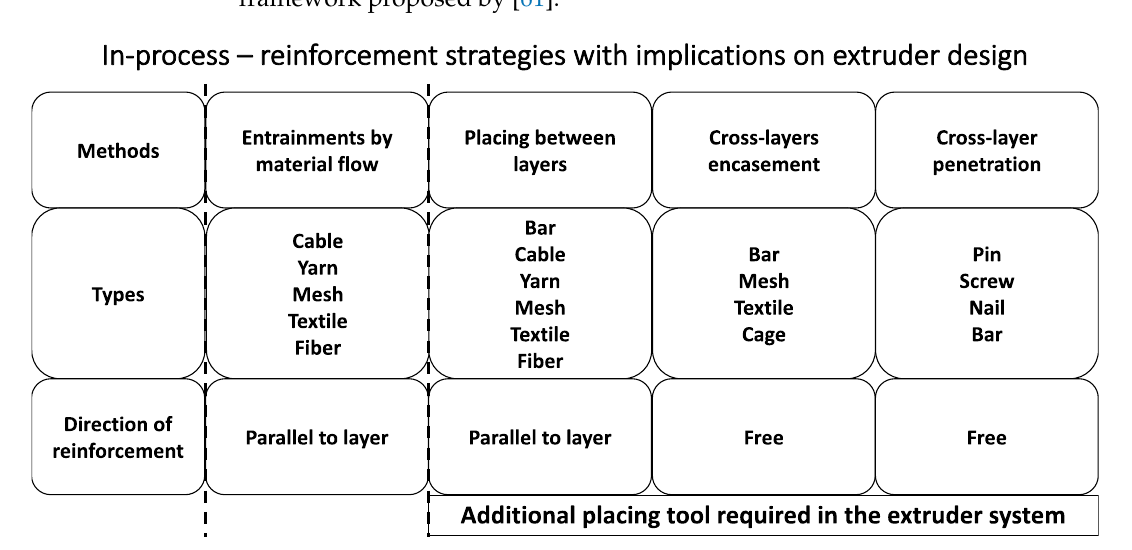
Figure 8. In-process reinforcement methods with implications on the extruder systems according to the process classification framework for integration of reinforcement into DFC technologies (PC4IR- DRC) [61].